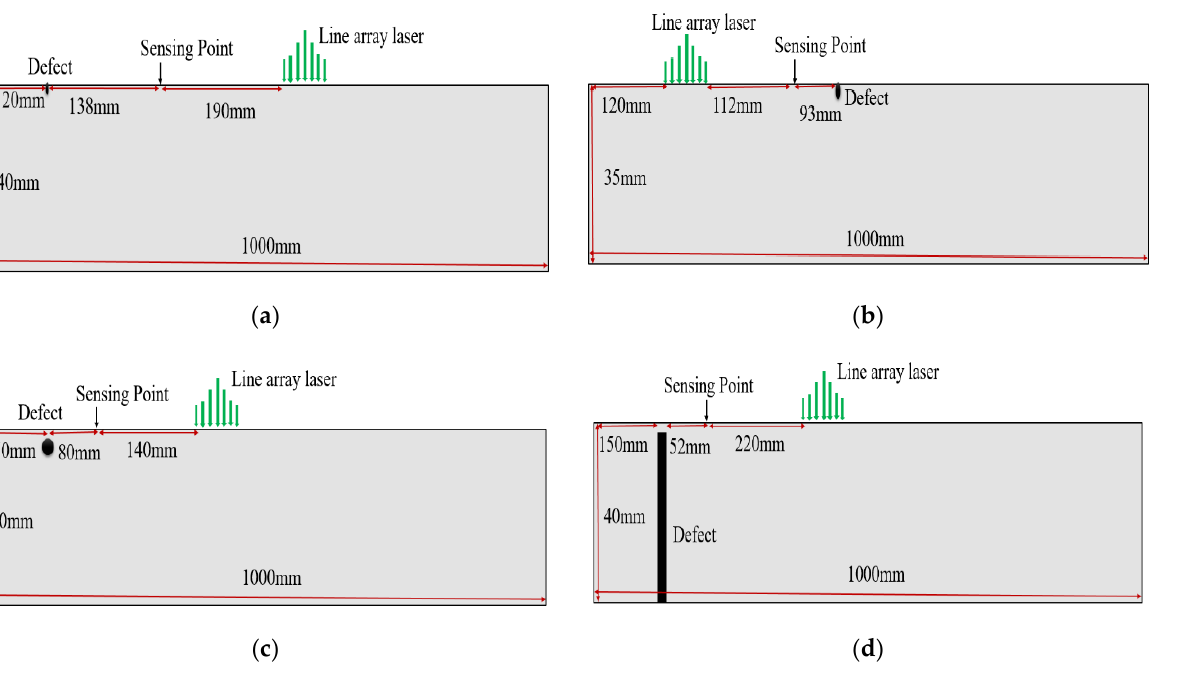
Figure 11. Schematic representation of the experimental arrangement for defect detection in railheads: ( a ) specimen B with surface horizontal defect, ( b ) specimen C with surface edge defect, ( c ) specimen D with subsurface horizontal defect and ( d ) specimen E with subsurface vertical defect.